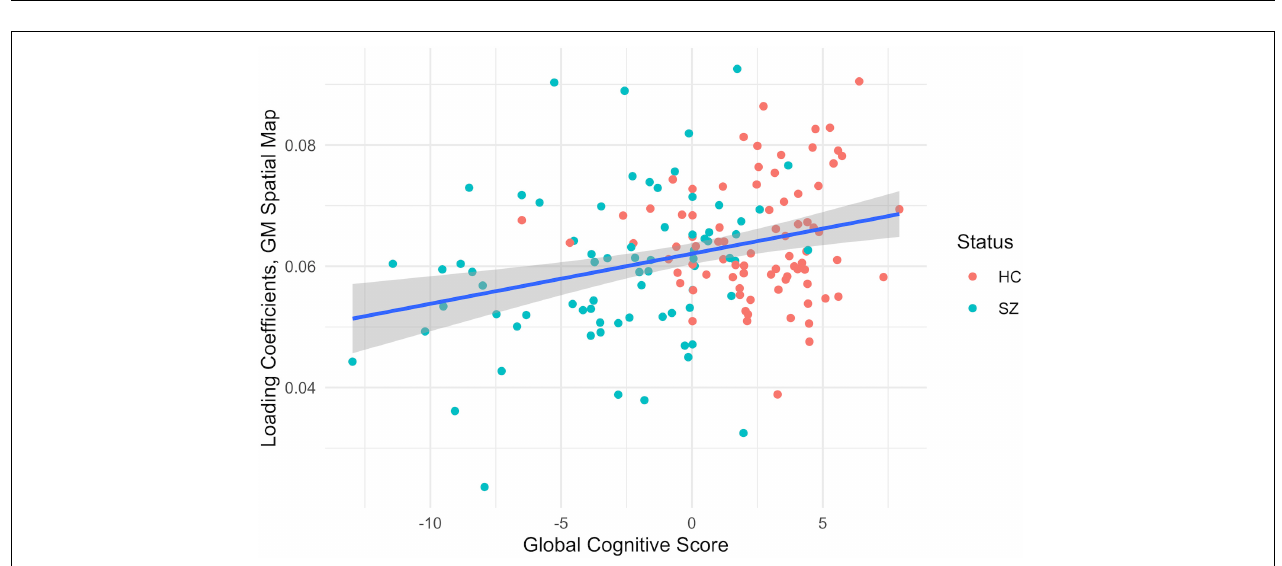
FIGURE 4 | MANCOVA results between the subjects’ gray matter loading coefficients from the second component pair (y-axis) and the global cognitive score (x-axis), F = 12.93, p < 0.001, corrected for multiple comparisons, healthy controls (HC) in red and patients with schizophrenia in teal (SZ). The gray shading indicates a confidence interval of 0.95.